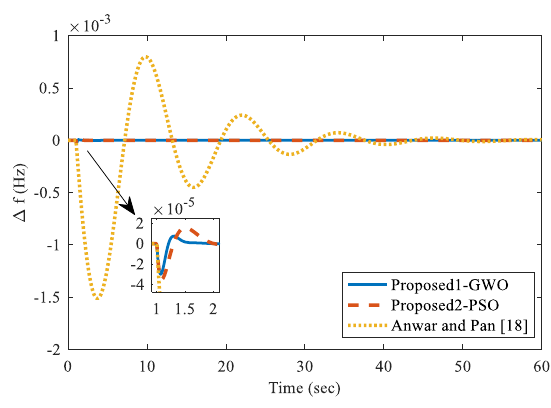
Fig. 6 Frequency regulation for case study 3